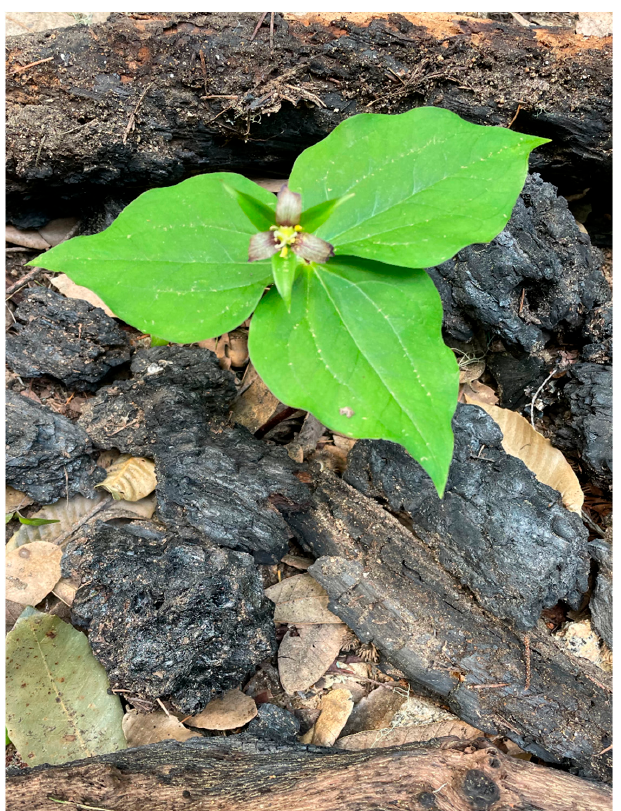
Figure 5. Perennial herb Trillium ovatum Pursh sprouting through charred fuel following a high severity crown fire.